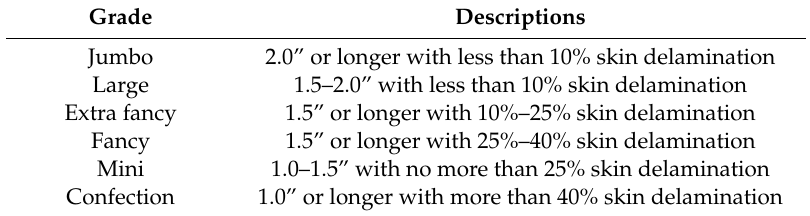
Table 1. Example of grading criteria for Medjool dates in Arizona and California, USA [9].